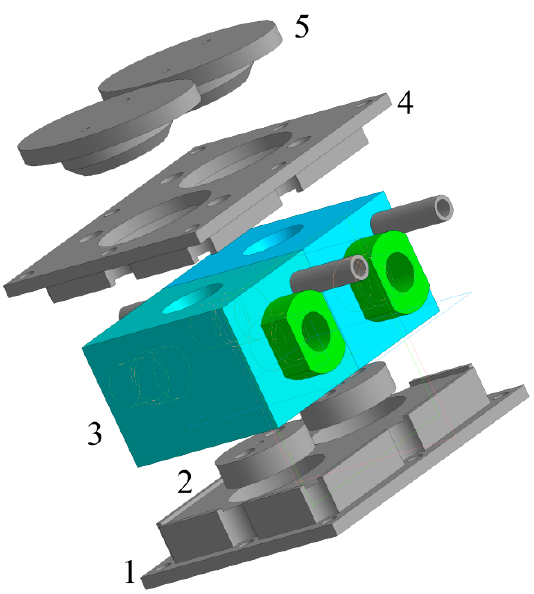
Figure 2. The 3D layout of the fixed-length ultrasonic spectrometer. (1) Bottom plate (PETG, 3D-printed); (2) magnet stirrer rotor (PETG, 3D-printed); (3) ultrasound measuring chambers (nickel-plated brass, machining); (4) top plate (PETG, 3D-printed); (5) caps (PETG, 3D-printed). DC brush motors, magnets 6 × 3, channels for supply/removal of gases to cells, and LEDs are not shown.